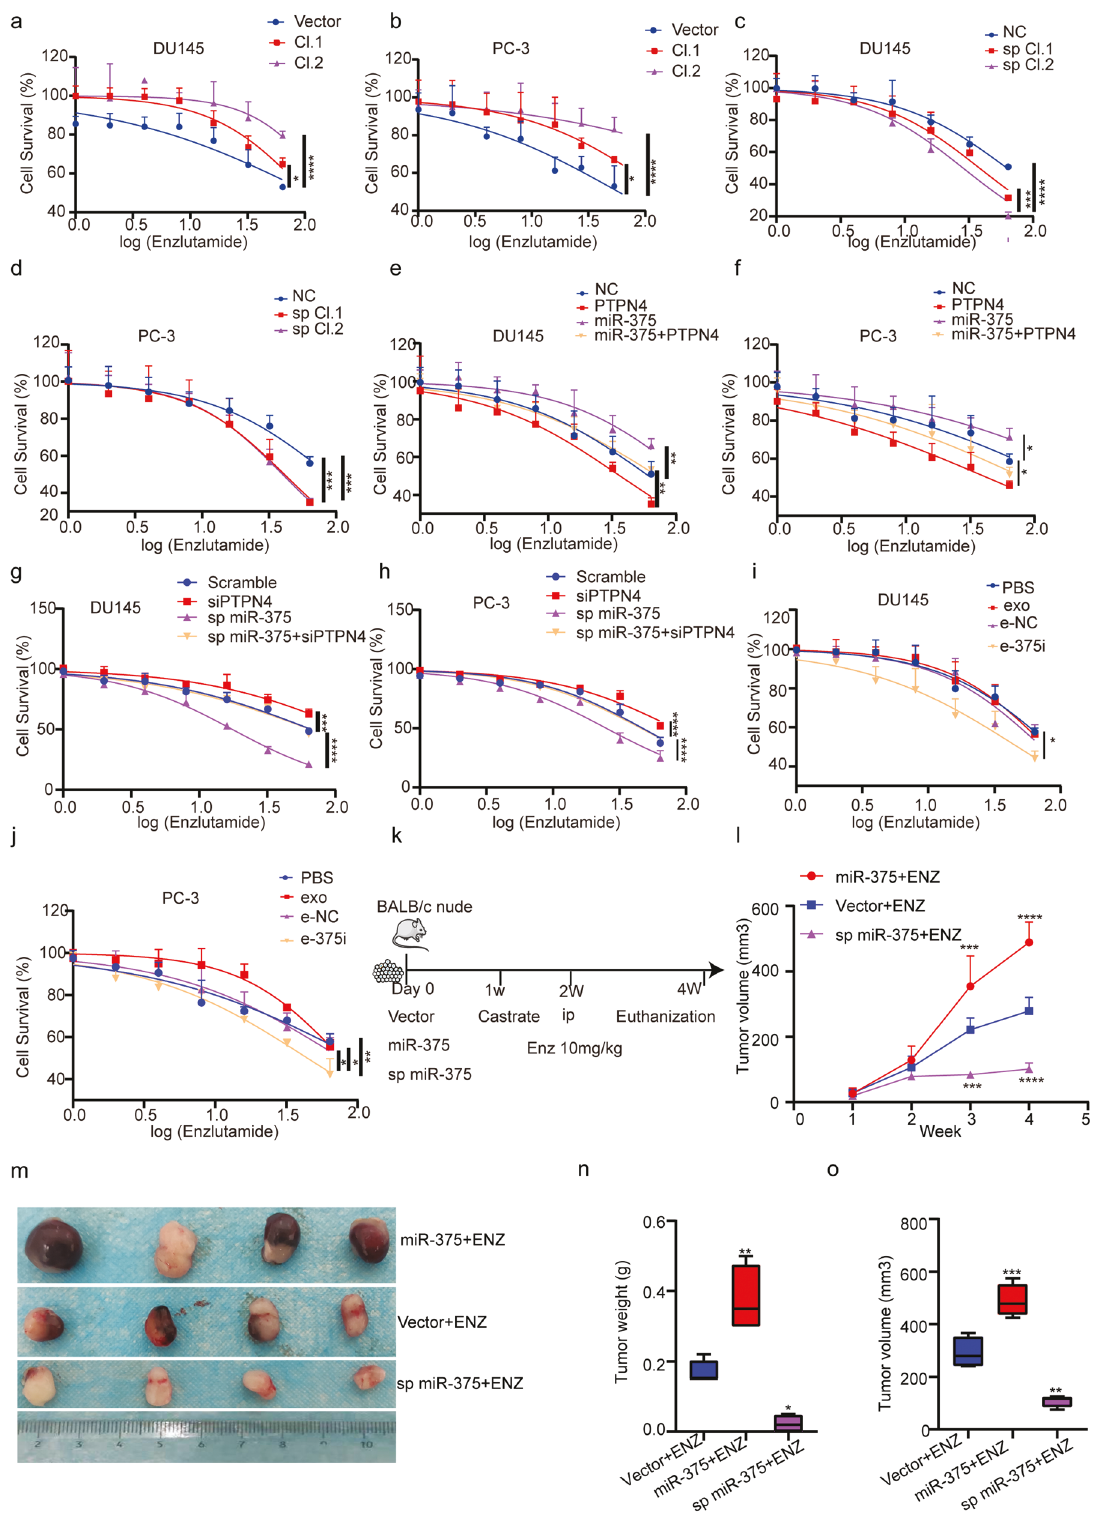
Fig. 9 MiR-375 regulated enzalutamide resistance by targeting the PTPN4-STAT3 signaling pathway in vitro and in vivo. CCK-8 assays were conducted to test enzalutamide resistance of DU145 and PC-3 cells in response to a , b stably upregulated expression of miR-375, c , d stable knockdown with miR-375 sponge, e , f overexpression of miR-375 and/or PTPN4, g , h suppression of miR-375 and/or PTPN4, and i , j the use of miR-e-375i. k A fl ow chart showing the in vivo experimental design. l Tumor volume during follow-up for 4 weeks. m Representative images of tumors in nude mice. n Final tumor weight, o fi nal tumor volume. ENZ: